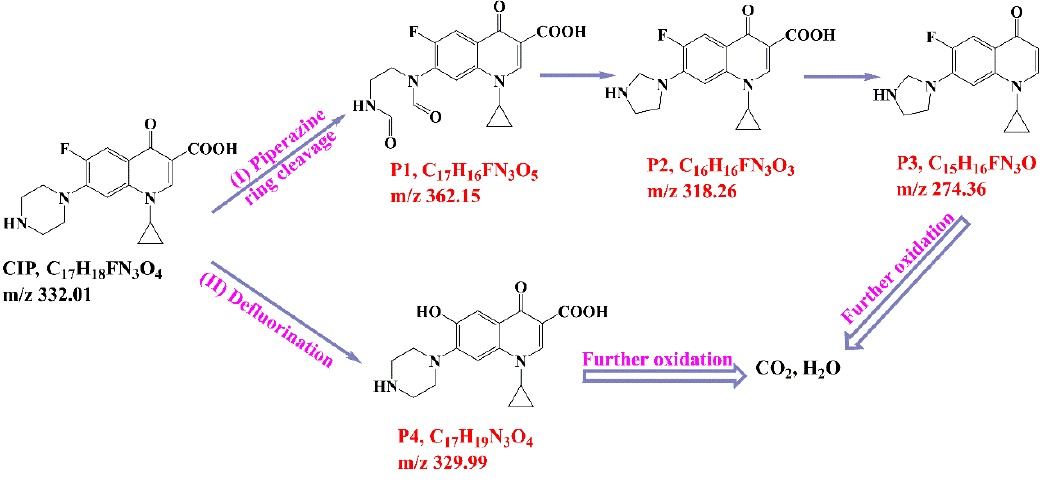
Figure 9. Possible degradation pathways for CIP by nZVI/PA.